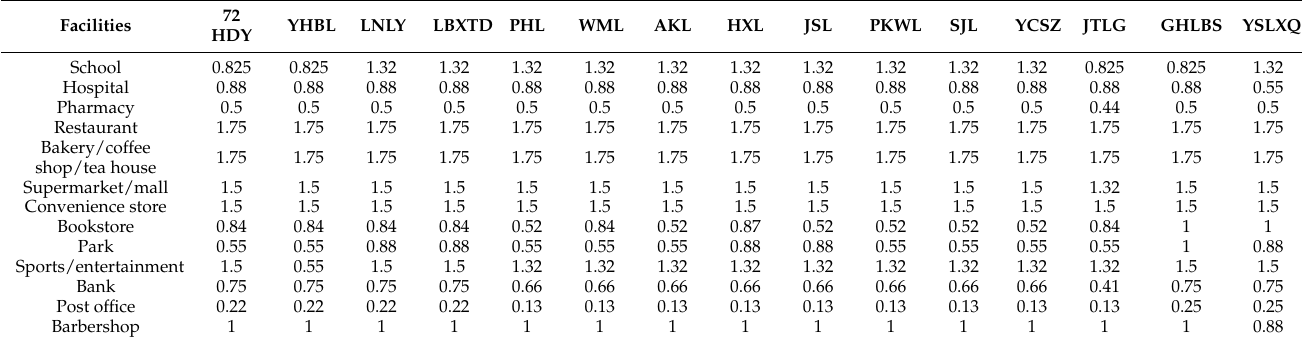
Table 6. Weight statistics of living facilities in low-score